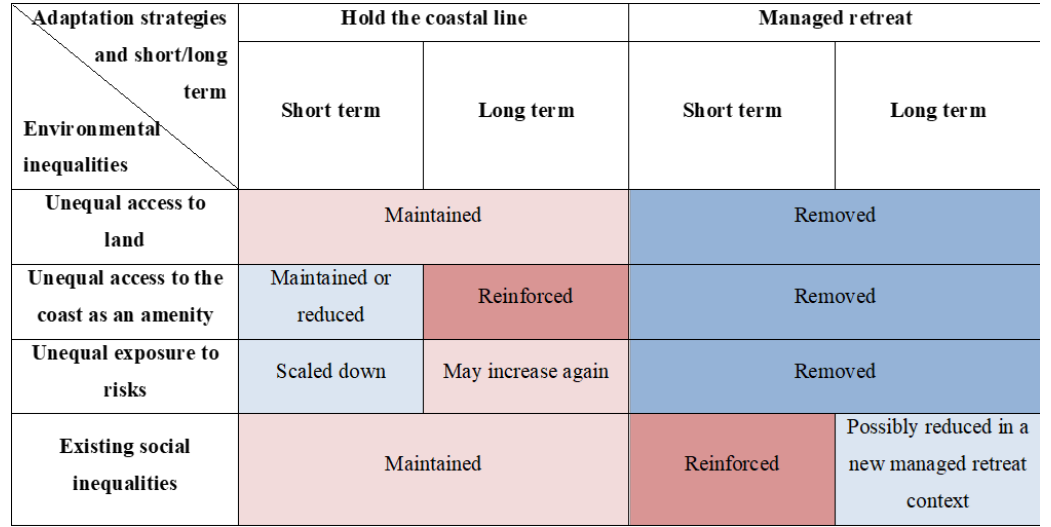
Figure 4. Evolution of cost and comparative advantages and drawbacks in the short and long term. Table 6. Evolution of environmental